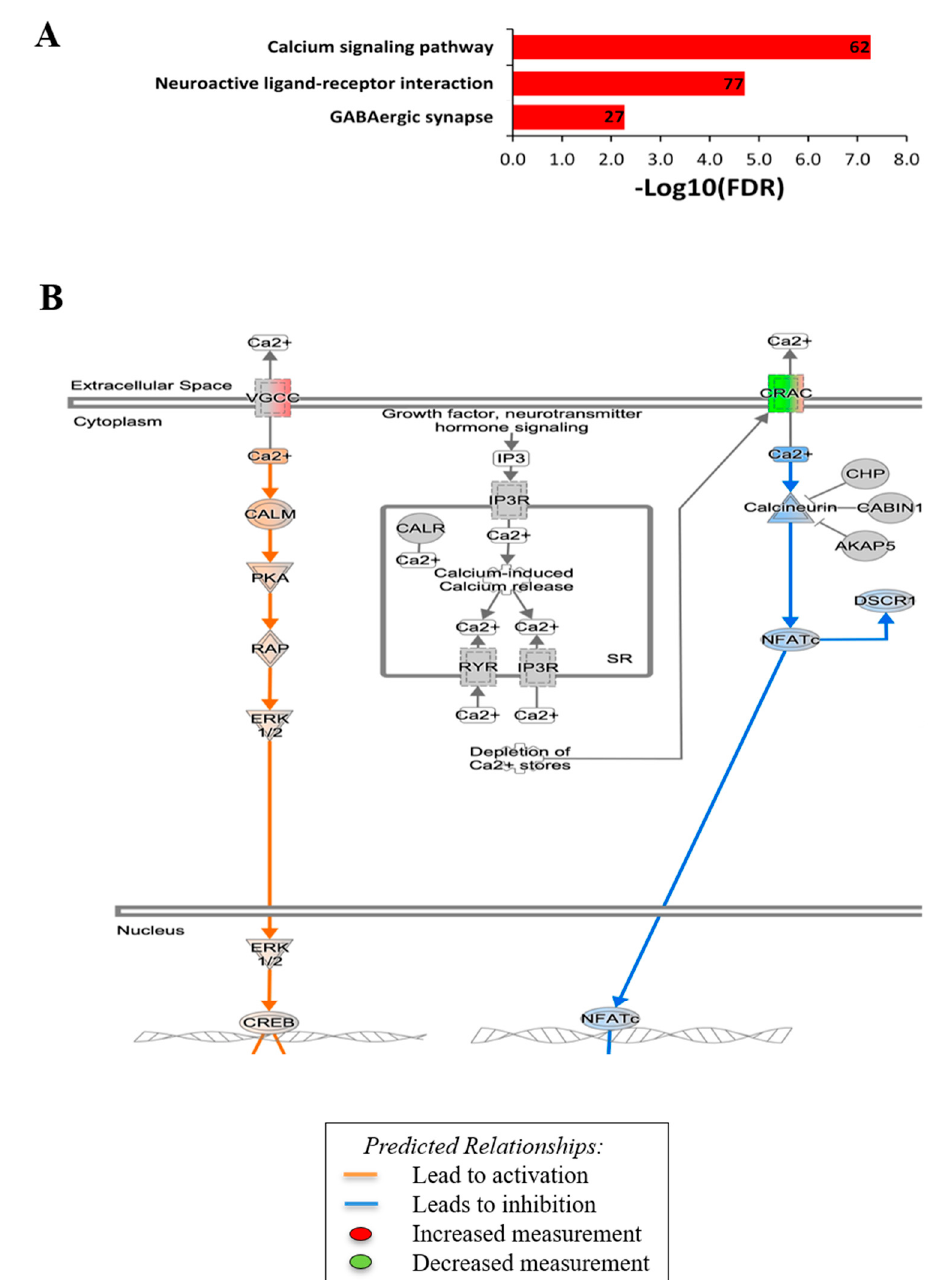
Figure 4. Upregulation of calcium signaling and cell growth events in MCs by ES. ( A ) Kyoto Encyclopedia of Genes and Genomes (KEGG) analysis showing the top three, particularly Ca 2+ ‐ mediated signaling pathway, identified with a high number of genes changed upon ES ‐ treatment (showed as numbers on the bars). ( B ) Schematic summary of ES ‐ induced signaling pathway changes as shown by KEGG pathway analysis of all DEGs showing significant upregulation of the calcium signaling pathway and cell growth while inhibition of NFATc pathway with overlaid predictions. Orange lines predict activation and blue lines indicate inhibition of the downstream signal. 3.3. The L ‐ type Calcium Channel Mediates ES ‐ induced MC Proliferation and Differentiation